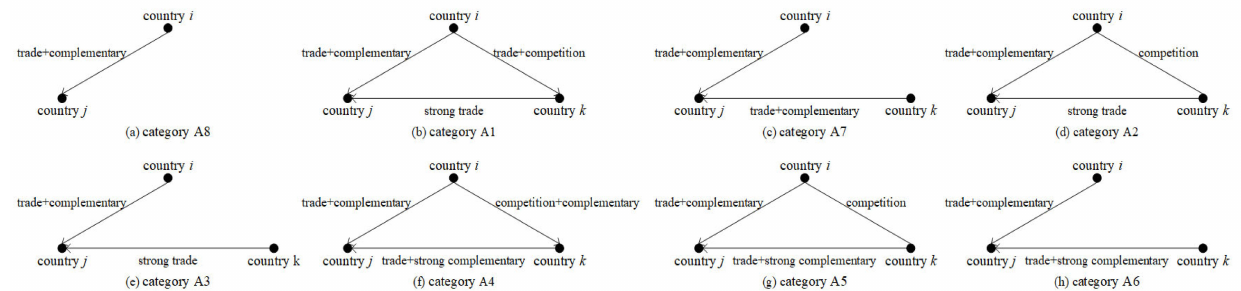
Figure 5. Classification of local network relations for category A key trading